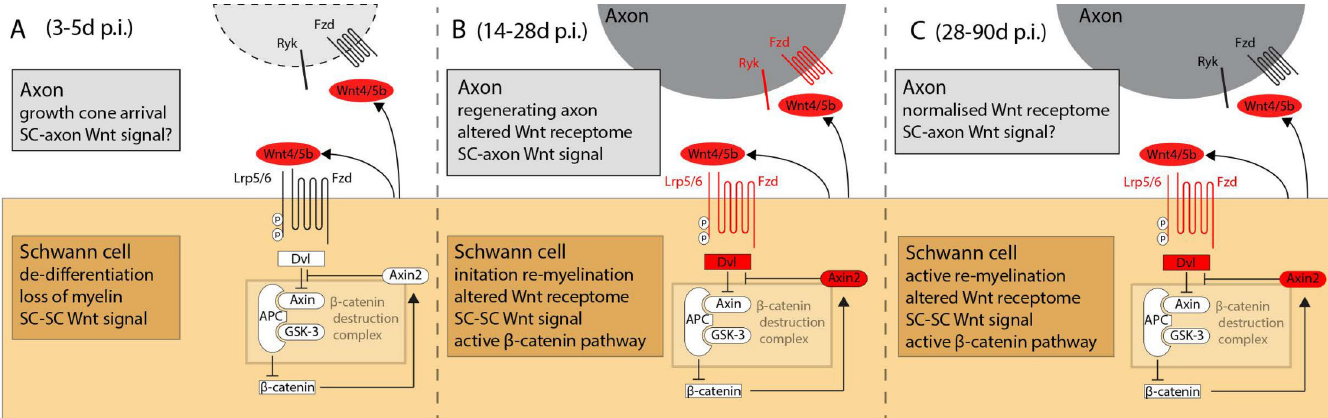
Fig 11. Overview of Wnt gene expression during regeneration in the injured rat nerve. A working model on how Wnt gene expression coincides with regenerative processes in the distal injured rat nerve. Red illustrates up-regulation. A , shows (early) denervated Schwann cells (bottom) as found in the injured distal peripheral nerve from 3-5d p.i. Schwann cells de-differentiate and produce Wnt4 and Wnt5b for autocrine and paracrine signalling, and possibly signal to arriving growth cones (top). B , shows recently regrown axons (top) at 14–28d p.i. together with Schwann cells (bottom) of the injured nerve. Schwann cells produce Wnt4 and Wnt5b to signal towards regenerating axons that have up-regulated multiple Wnt receptors including Ryk. Wnt5b and Wnt5 also mediate Schwann cell autocrine signalling, at 14d p.i. through altered Wnt receptor availability initiates differentiation and re-myelination due to activation of the β -catenin pathway as demonstrated by Axin2 up- regulation. C , exhibits the late regenerative response at 28–90d p.i., with regrown axons (top) and a re-myelinating Schwann cell (bottom). Re- myelinating Schwann cells still produce Wnt4 and Wnt5b but axons have returned their Wnt receptor expression to baseline. Schwann cells signal with Wnt ligands in an autocrine fashion to stimulate the β - catenin pathway as indicated by Axin2